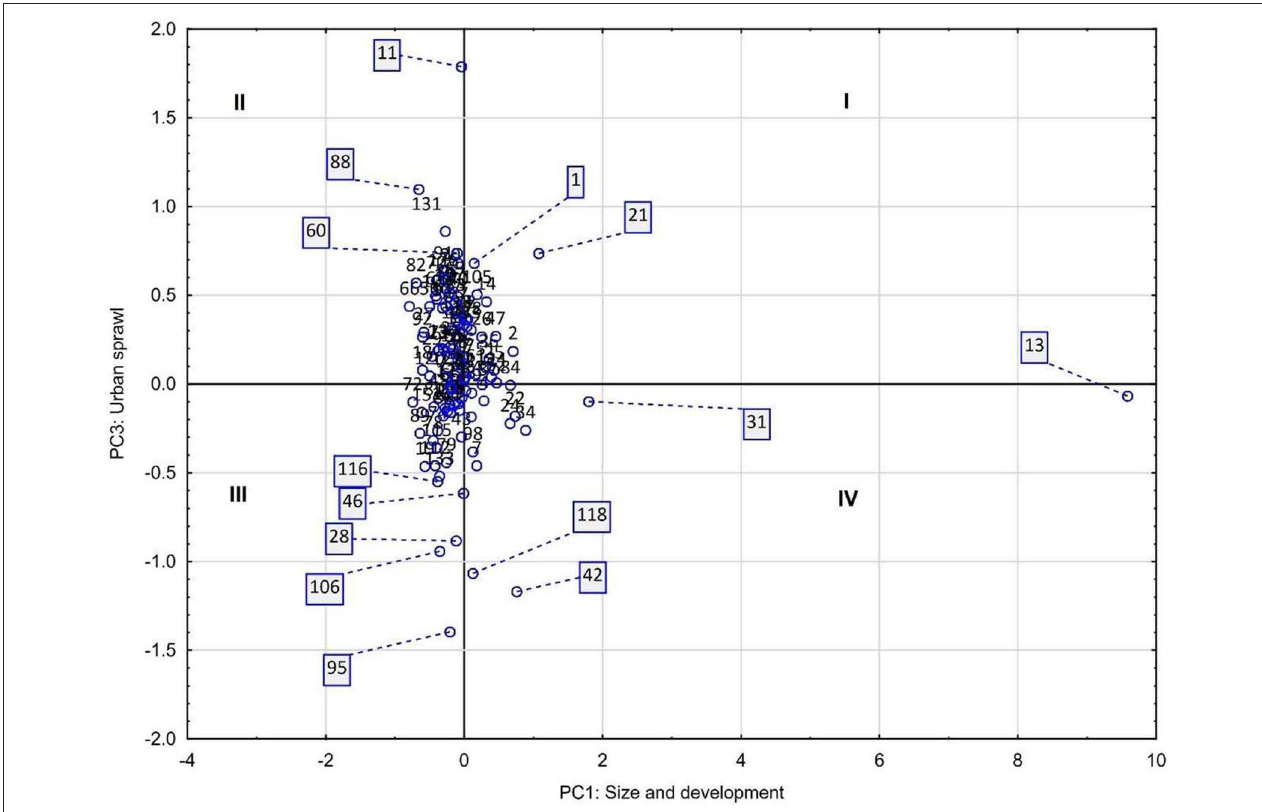
FIGURE 2 | Scatter plot of city size and development index (PC1) and urban sprawl index (PC3). Cozumel is an outlying value in PC3 and it was excluded from the figure to improve clarity. A list of names and ID numbers of Mexican cities is provided in Table A2